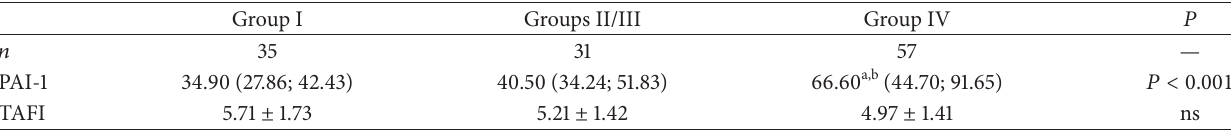
Table 2: Plasma fibrinolytic markers.